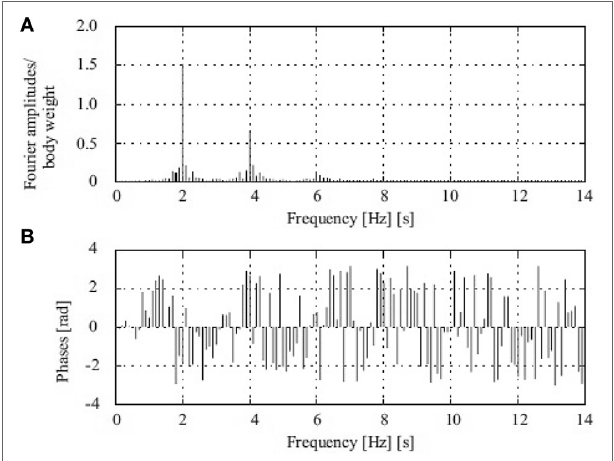
FiGURe 8 | Fourier (A) amplitudes and (B) phase lags up to 14 Hz derived from 10 s of the force record due to a single person jumping at 2 Hz. Reprinted from (Racic and Pavic, 2009) with permission from